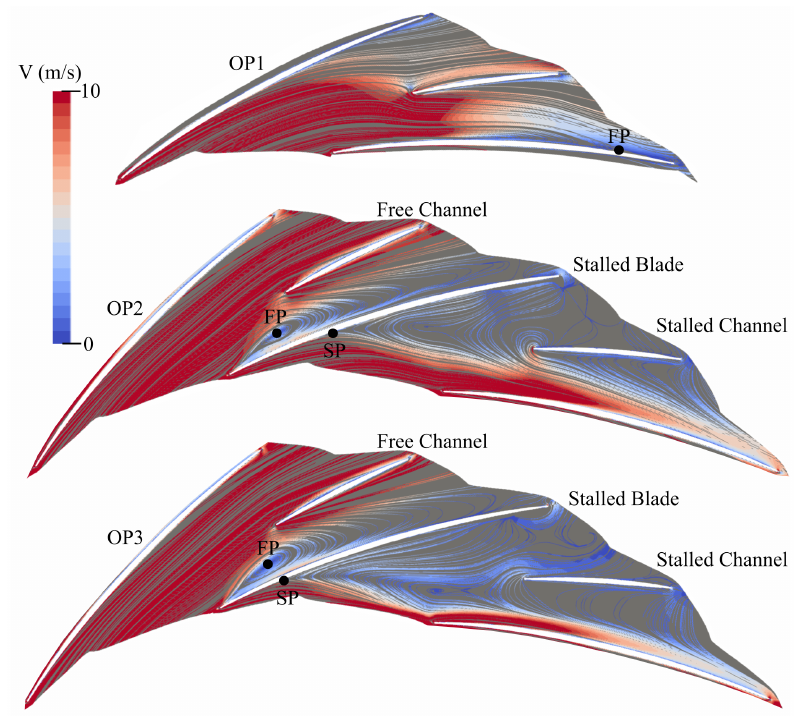
Figure 12. Change in streamlines colored by the velocity at the hub with decreasing mass flow